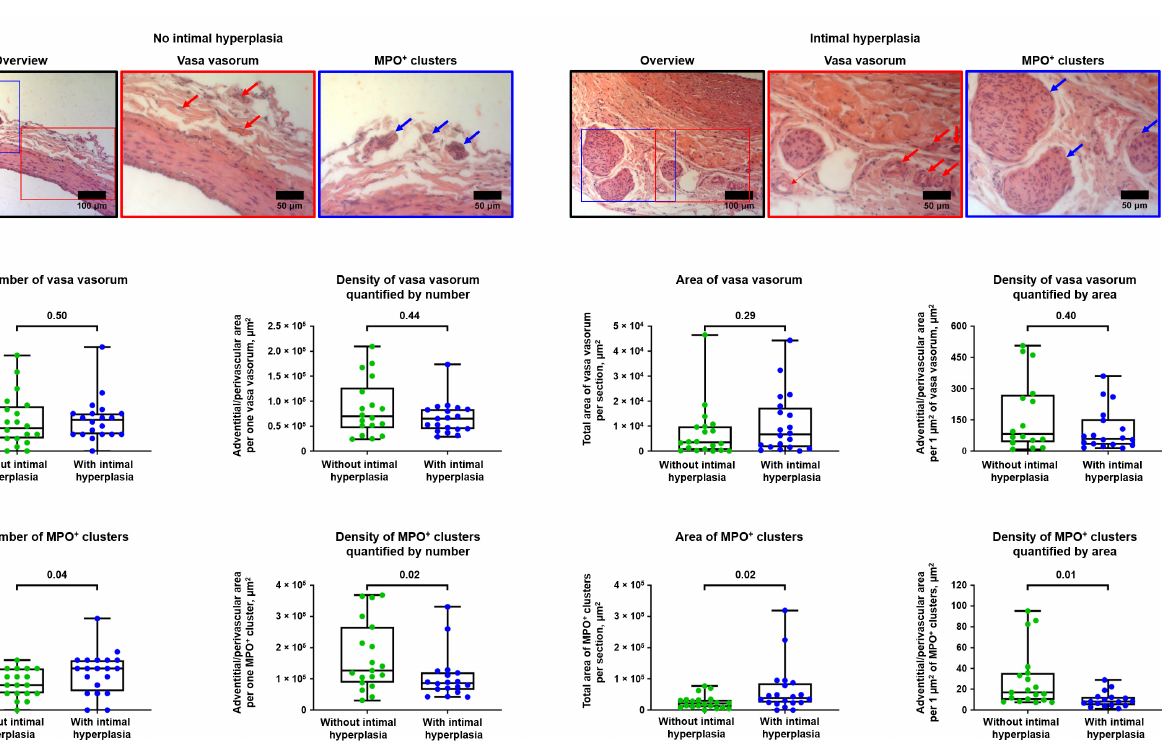
Figure 3. Balloon-induced IH is associated with the expansion of VV and development of MPO + clusters. ( A ) Representative images showing VV and MPO + clusters in rats with or without IH in the abdominal aortas 5 weeks upon the balloon angioplasty. Red and blue contours demarcate the close-ups of the areas with representative VV and MPO + clusters, respectively. Red and blue arrows indicate VV and MPO + clusters, respectively. Haematoxylin and eosin staining, × 200 magnification (scale bar: 100 µ m) and × 400 magnification (scale bar: 50 µ m); ( B ) Quantitative analysis of number, area, and density of VV in rats from the experiment in A. Each dot represents an aortic section from one rat. Whiskers indicate range, box bounds indicate 25th–75th percentiles, center lines indicate median. p -values provided above boxes, Mann–Whitney U-test; and ( C ) Quantitative analysis of number, area, and density of MPO + clusters in rats from the experiment in A. Each dot represents an aortic section from one rat. Whiskers indicate range, box bounds indicate 25th–75th percentiles, center lines indicate median. p -values provided above boxes, Mann–Whitney U-test. IH—intimal hyperplasia, VV—vasa vasorum, and